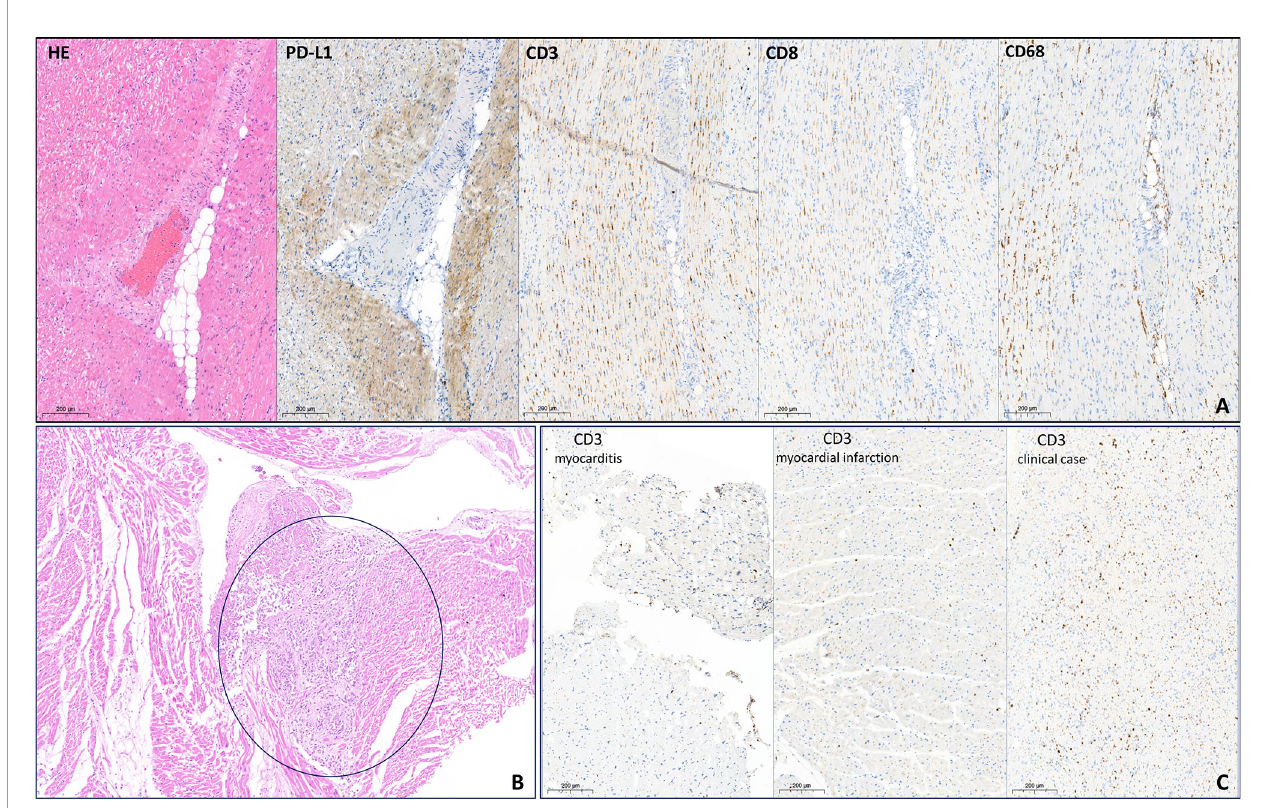
FIGURE 3 | Histopathological evaluation of myocardium. (A) H&E and immunohistochemistry examination of myocardium free from metastasis. PD-L1 demonstrates cytoplasmic, membrane, and intravascular expression patterns. High in fi ltration of CD3 and CD68 cells and moderate in fi ltration of CD8 cells. (B) H&E. Subendocardial mucinous carcinoma micrometastases (circled in blue). (C) Comparison of CD3 expression in no-ICI-associated active lymphocytic myocarditis (>25 cells/mm 2 ), in acute myocardial infarction (~15 cells/mm 2 ), and in the patient after atezolizumab infusion (>50 cells/mm 2 ). ICI, immune checkpoint